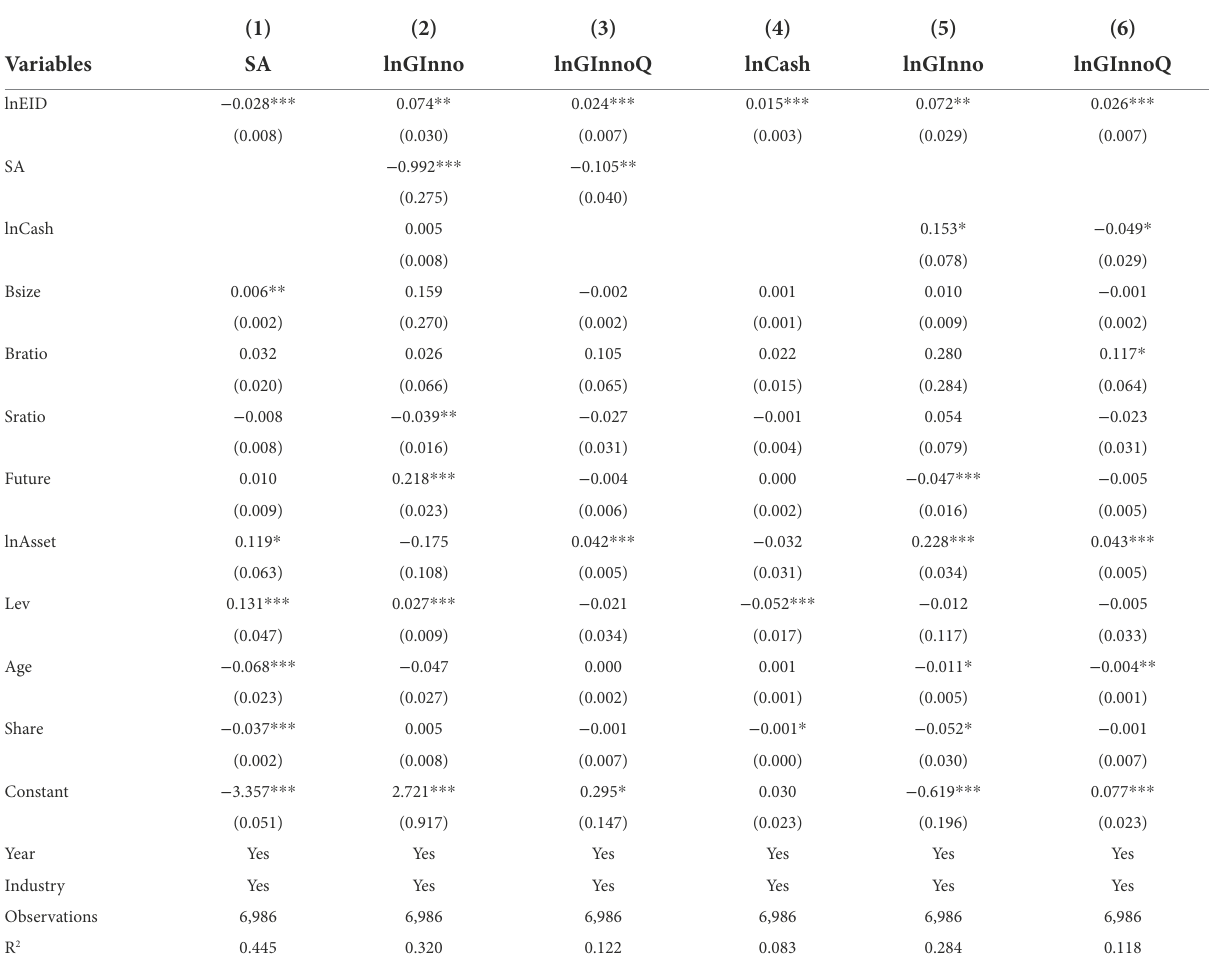
TABLE 5 Mediating effect